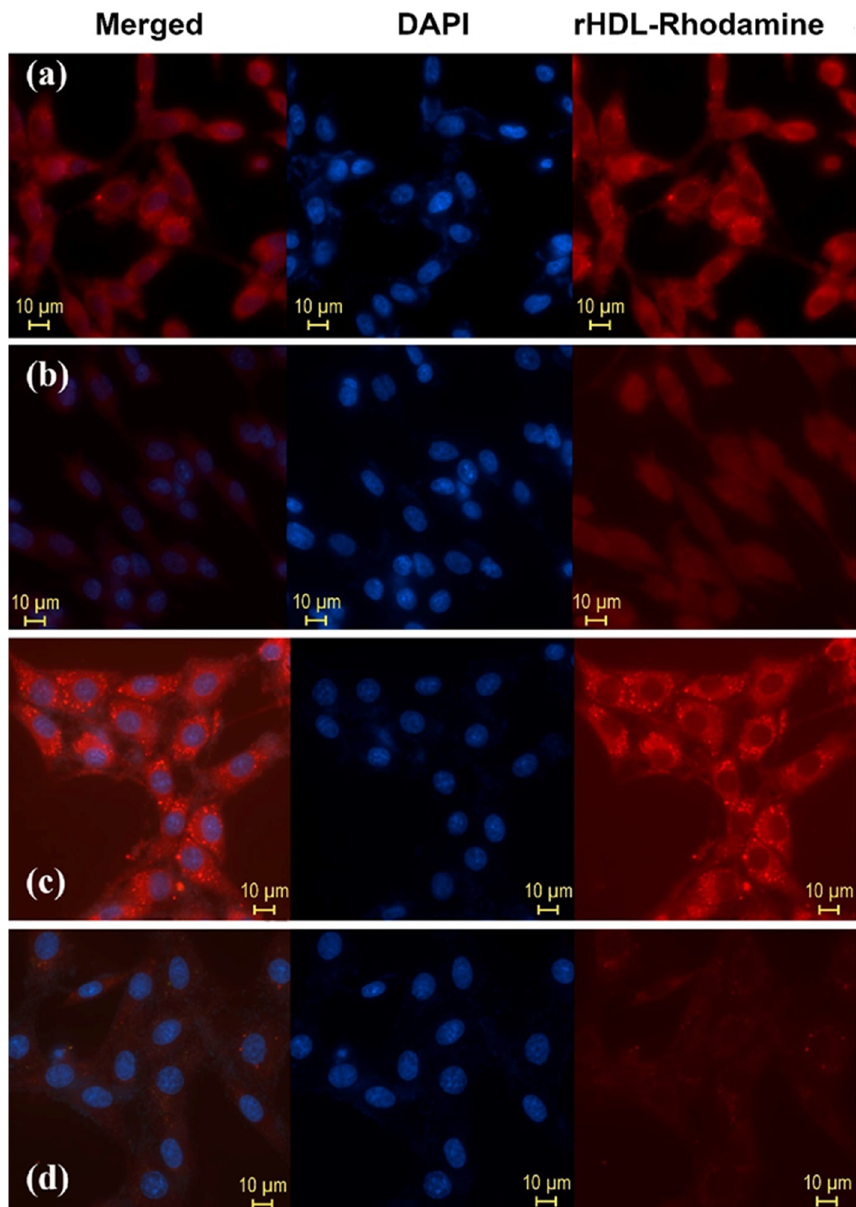
Figure 5. Internalization in T47D cells (SR-B1+) (release to cytosol) of Rhodamine 6G used as cargo in ( a ) HYNIC-rHDL nanoparticles, ( b ) HYNIC-rHDL nanoparticles with SR-B1 receptor blocking effect (T47D cells pretreated with 200 µ L of Apo-A1, 1 mg/mL, in the form of empty rHDL), ( c ) DOTA-rHDL nanoparticles, and ( d ) DOTA-rHDL nanoparticles with SR-B1 receptor blocking effect (T47D cells pretreated with 200 µ L of Apo-A1, 1 mg/mL, in the form of empty rHDL). Observe the intensity of Rhodamine fluorescence when it is internalized in TD47 cells due to its release from the rHDL core to the cytosol after the specific interaction of Apo-A1 (present on the surface of the rHDL nanoparticle) with SR-B1 (highly expressed on the surface of TD47 cancer cells).